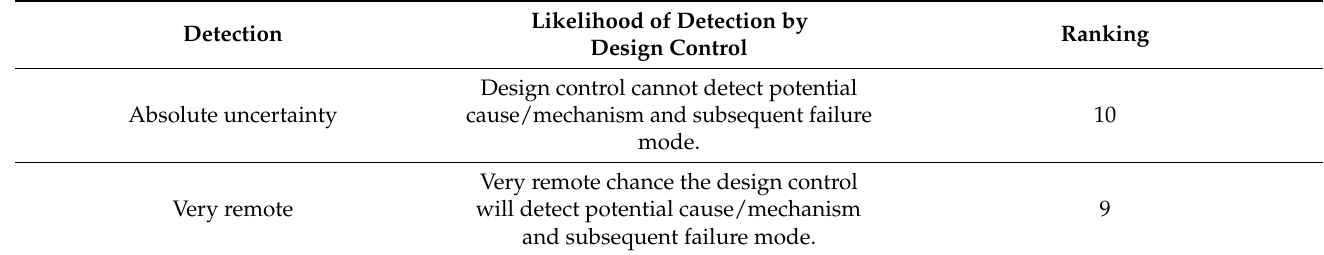
Table A5. Detectability